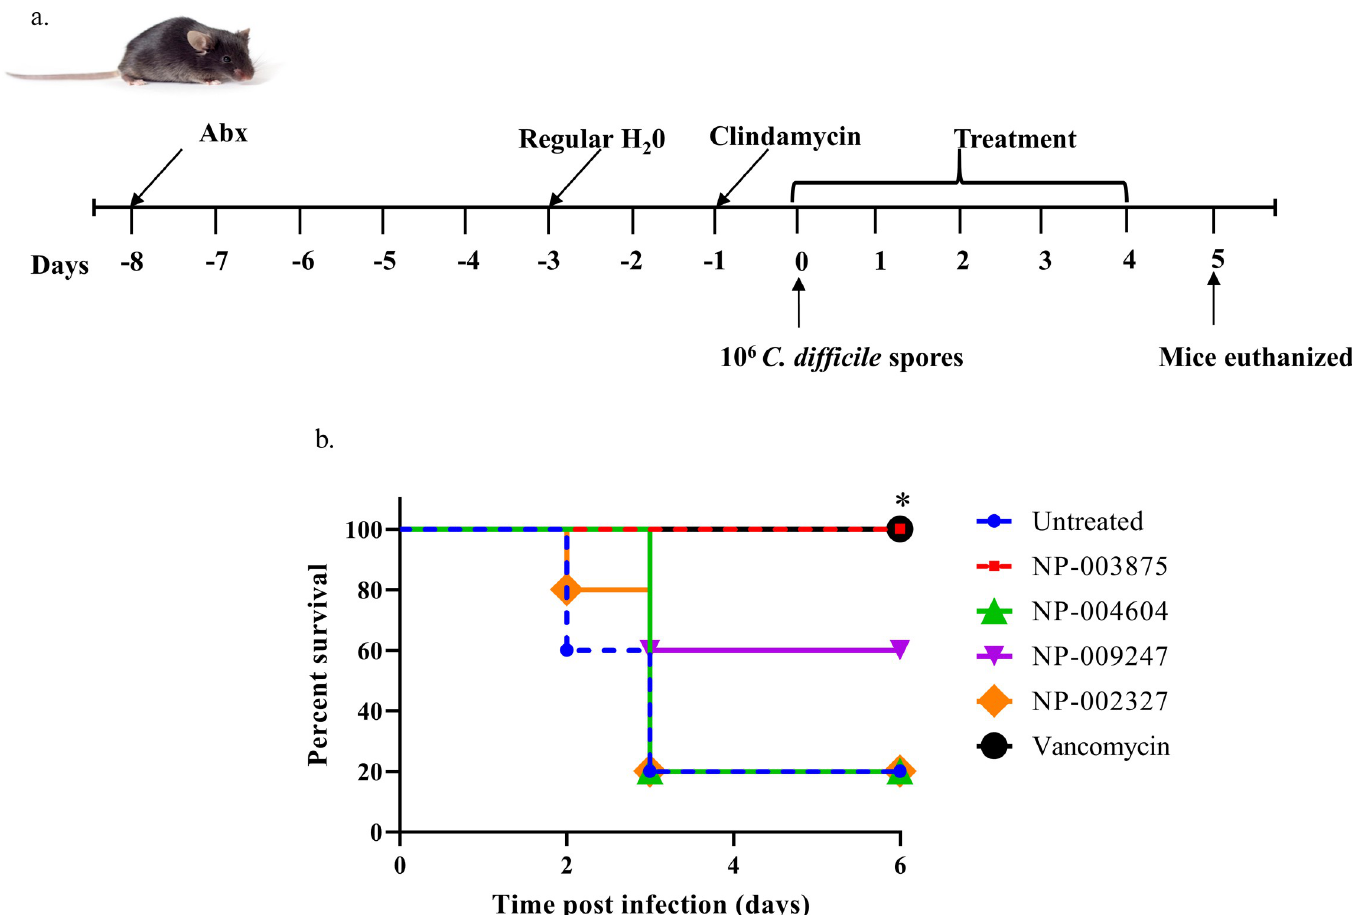
Fig 5. Murine model of CDI. (A) Schematic of mice model. 6-week-old female mice were randomly divided into groups (n = 5 per group). Mice were given antibiotic water consisting of kanamycin (0.4 mg/ml), colistin (850 U/ml), gentamicin (0.035 mg/ml), vancomycin (0.045 mg/ml), and metronidazole (0.215 mg/ml) for 5 days. Clindamycin (10 mg/kg) was injected intraperitoneally a day before infection. C . difficile spores were administered via oral gavage on Day 0. Treatment was initiated on Day 0 and continued for 5 days. A single dose of each drug was administered via oral gavage daily. (B) The Kaplan-Meier survival curve was analyzed using a log-rank (Mantel-Cox) test. Significant difference was noted between the survival curves of the mice treated with NP-003875 vs. untreated control (100% vs. 20%; p = 0.0144).